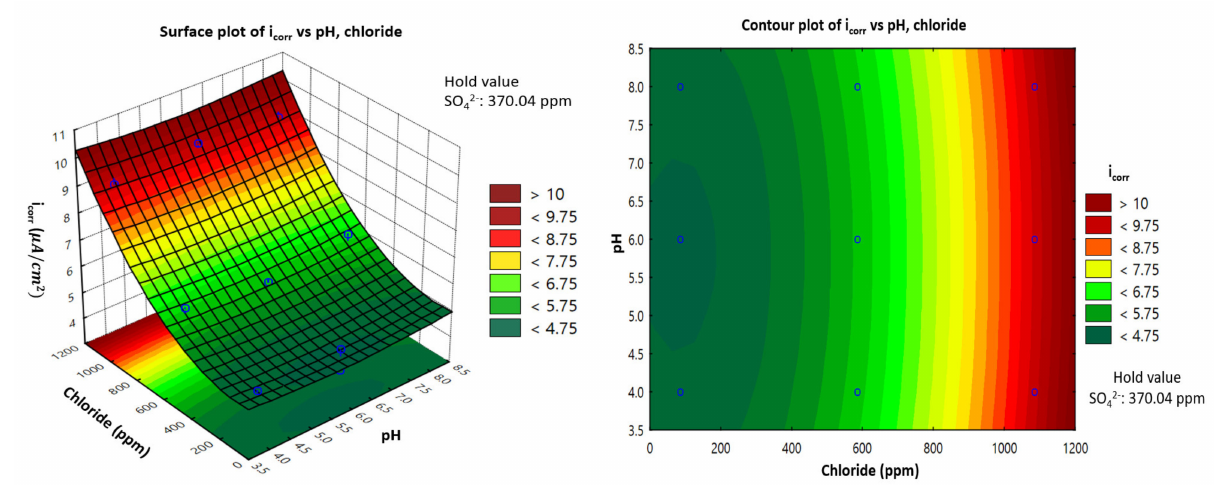
Figure 5. Response surface and contour plots showing the effect of pH and chloride concentration on the corrosion current density ( i corr ) of carbon steel in a soil environment.